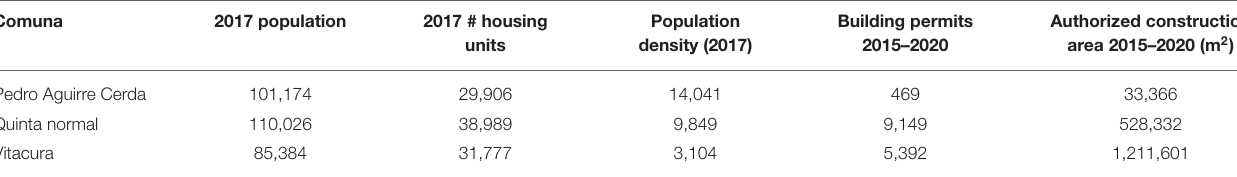
TABLE 1 | Characteristics of the three comunas where Santiago parks are